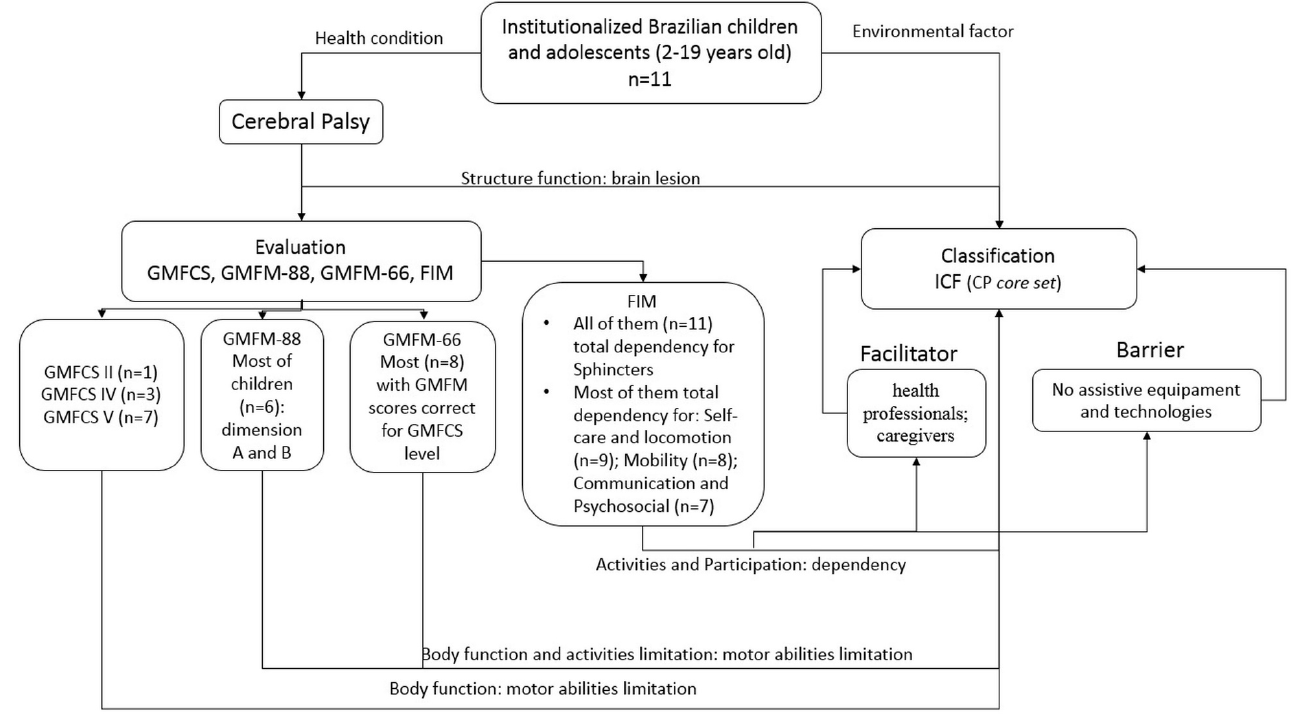
Figure 2- Characterization of institutionalized Brazilian children with CP by the ICF